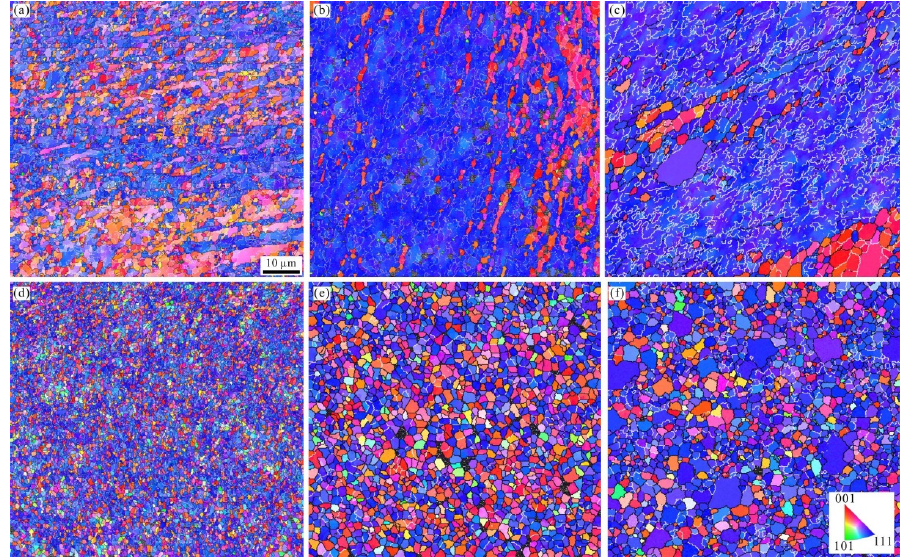
Figure 5. The radial orientation distribution maps of ( a ) the cold-drawn CPAW, ( b ) the CPAW annealed at 90 °C for 8 h, ( c ) the CPAW annealed at 250 °C for 8 h, ( d ) the cold-drawn AFW, ( e ) the AFW annealed at 200 °C for 8 h, ( f ) the AFW annealed at 250 °C for 8 h. Equation (3) was used to calculate the volume fraction of texture to quantitatively display the texture distribution: